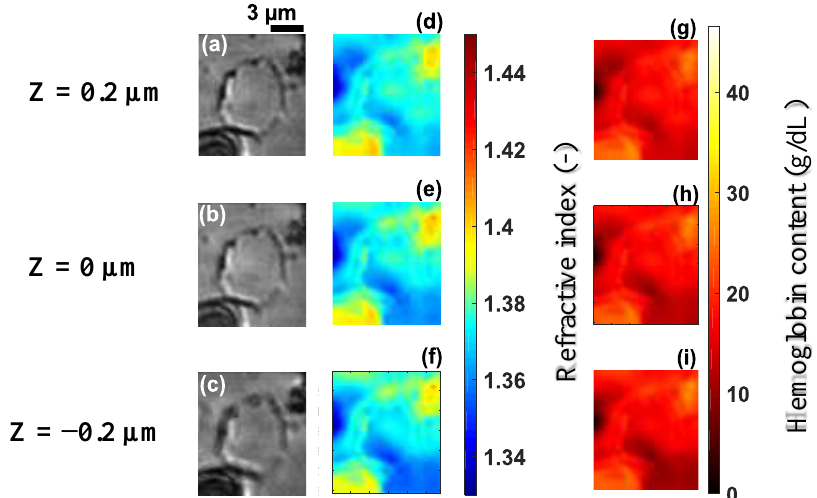
Figure 9. Recorded images of infected cell E at the schizont stage, at the wavelength λ = 800 nm for different z planes ( a )–( c ), its corresponding refractive index distribution ( d )–( f ) and hemoglobin content ( g )–( i ). The selected images are representative of a total of 28 cells analyzed.